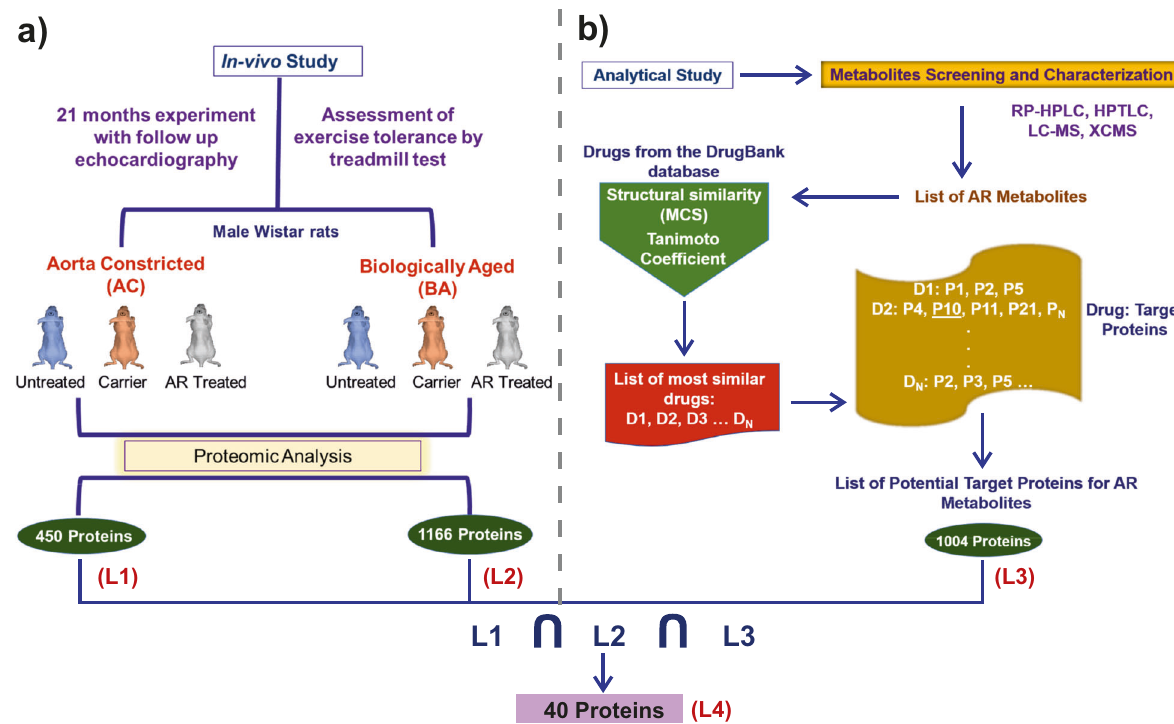
Fig. 1 in-vivo studies and data extraction. a Illustration presenting an overall schematic representation of the in-vivo study performed on male Wistar rats for 21 months 28 . The proteins from the AC and BA samples were identi fi ed by proteomic analysis and designated as L1 and L2, respectively. b The AR composition was identi fi ed by mass spectroscopy techniques. The AR constituent metabolites, thus identi fi ed were used to search structurally similar drugs in the DrugBank database. Further, the targets corresponding to the highest-ranked drug molecules were identi fi ed to relate their activity against each metabolite (L3). The intersection of L1, L2, and L3 had 40 proteins (L4). These proteins represent the set of proteins targeted by various AR metabolites, which leads to the drug action of the AR concoction. Therefore, we used list L4 for our further